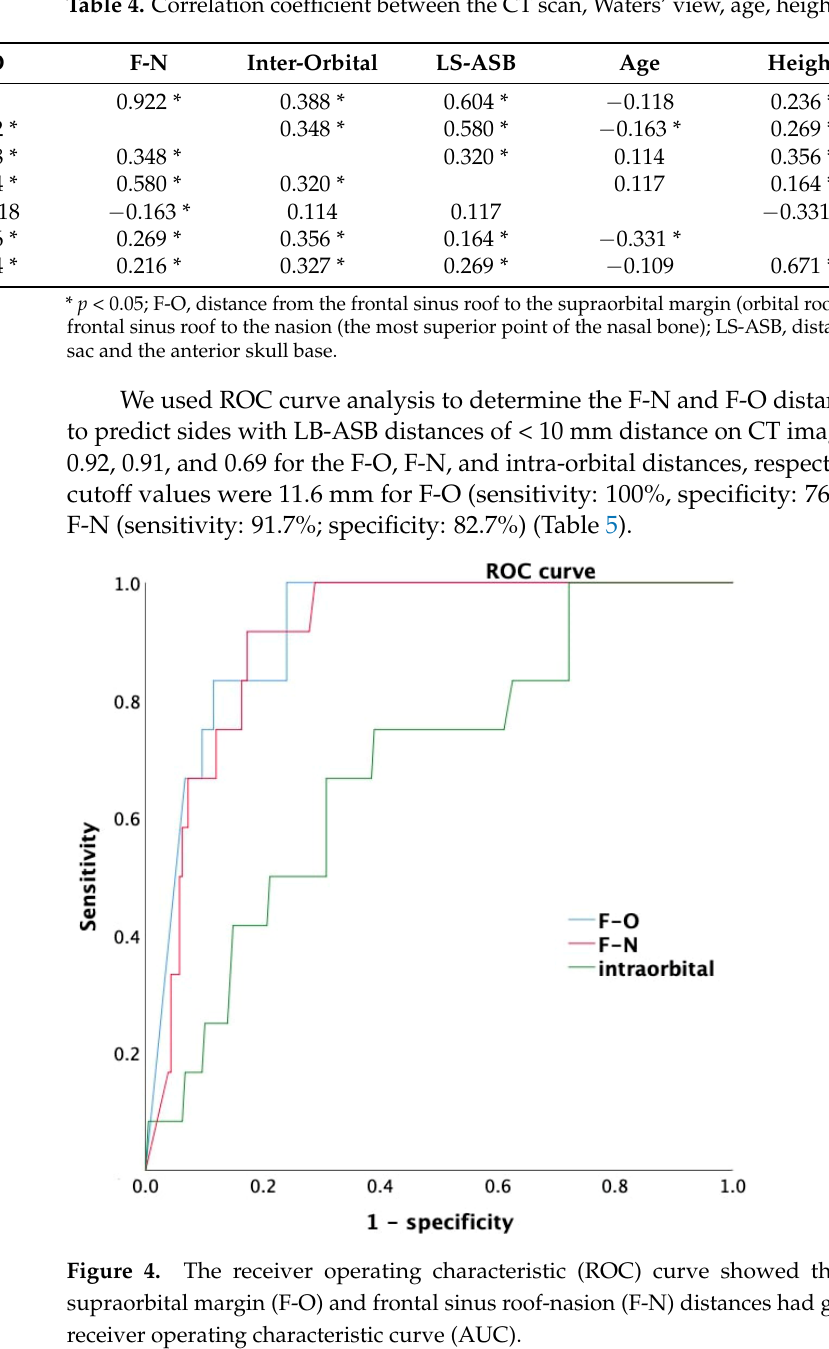
Table 4. Correlation coefficient between the CT scan, Waters’ view, age, height, and weight.